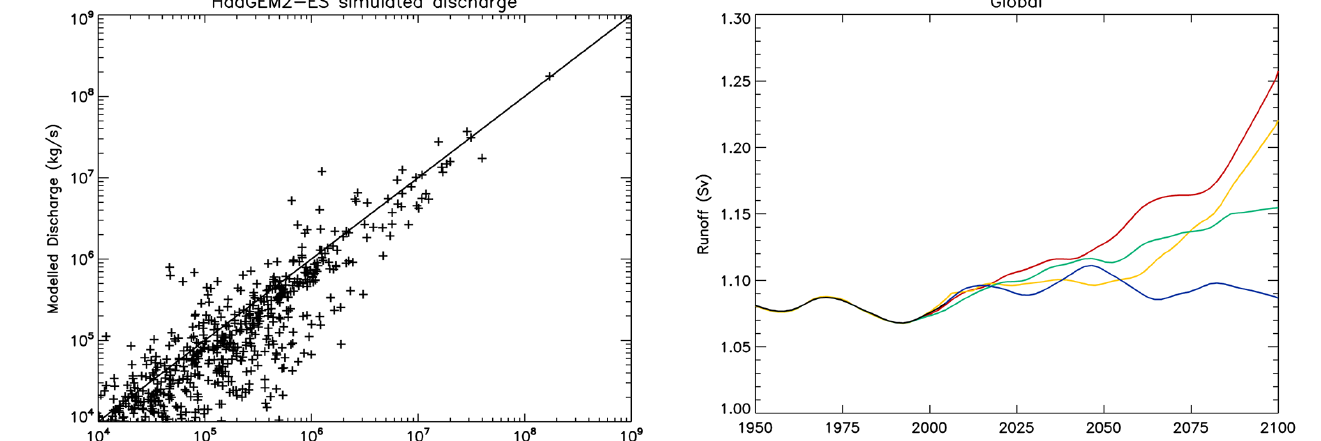
Figure 17. Global total river flow simulated by HadGEM2-ES un- der historical forcing prior to 2000 and the RCPs over the 21st cen-